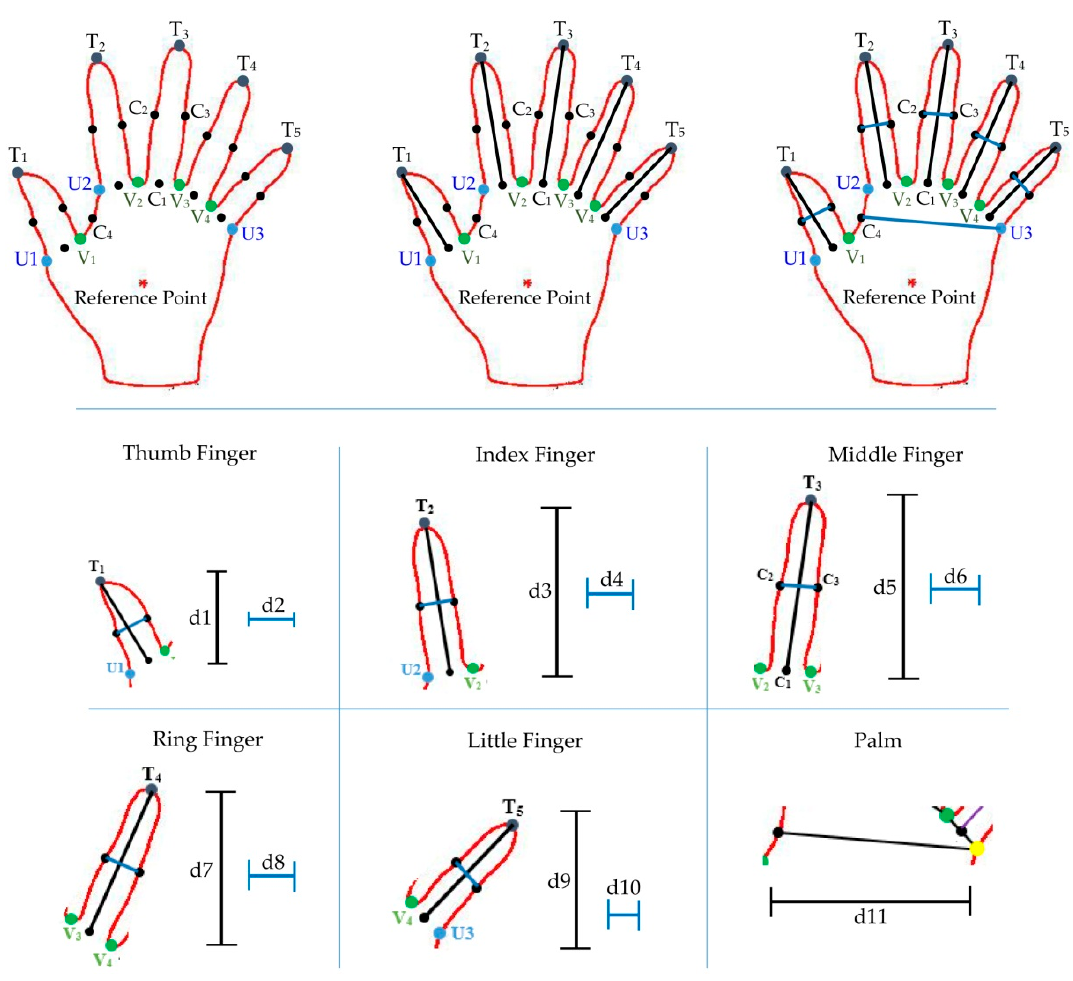
Figure 20. Feature extractions.